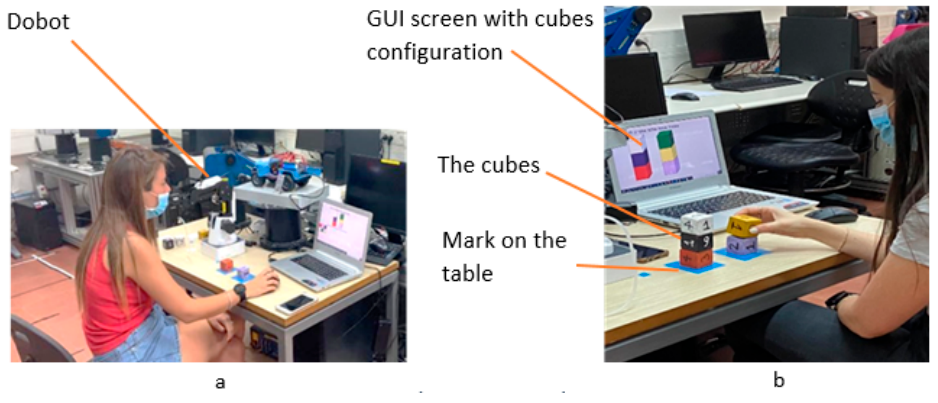
Figure 1. The experimental system.